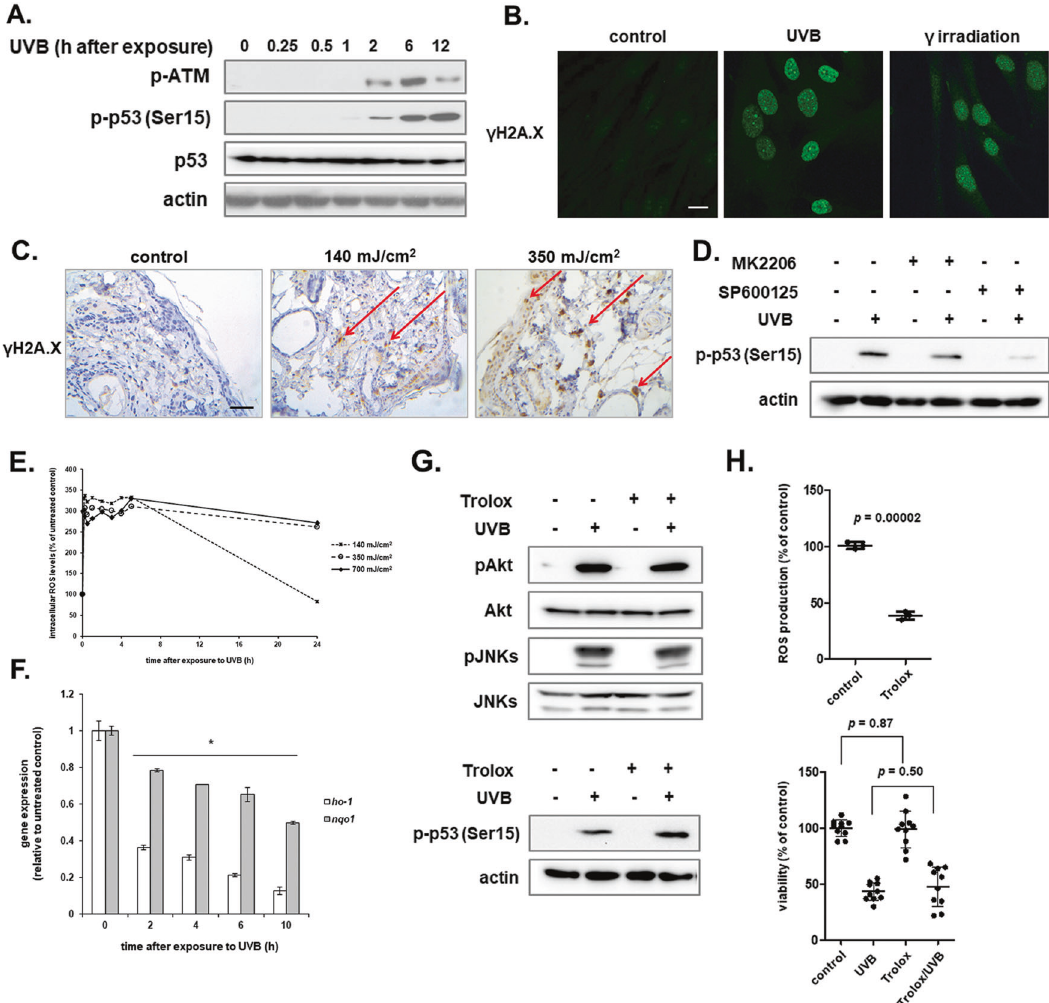
Fig. 3 UVB radiation exerts a ROS-independent genotoxic effect on human dermal fi broblasts in vitro and in vivo. A Cells were exposed to 700 mJ/cm 2 of UVB radiation before protein extraction at the designated time-points post-irradiation and western blot analysis for phopsho- ATM, phospho-p53, and total p53. Western blot analysis for actin was performed to verify equal loading. Experiments were repeated three times and representative blots are presented. B Skin fi broblasts were cultured on glass coverslips before UVB treatment with 700 mJ/cm 2 and further incubated at 37 o C for 24 h. They were then fi xed with 4% (w/v) formaldehyde followed by labeling using an antibody against phospho-H2A.X at Ser139 and a FITC-conjugated IgG. Labeled cells were visualized using a confocal laser scanning microscope. Cells exposed to 10 Gy of ionizing radiation served as the positive control. Representative images of three independent experiments are shown here. Scale bar = 20 μ m. C SKH-1 hairless mice were exposed to 140 and 350 mJ/cm 2 of UVB radiation before sacri fi ce and removal of dorsal skin 6 h post- irradiation. Non-irradiated (control) vs. irradiated tissue sections were subjected to immunohistochemical staining for the phosphorylated form of H2A.X at Ser139. Pictures shown here are representative of three independent experiments and arrows depict γ H2A.X-positive cells in the epidermis and dermis of SKH-1 hairless mouse skin. Scale bar = 50 μ m. D Cell cultures were pre-incubated with 1 μΜ of the Akt inhibitor MK2206 and 5 μΜ of the JNKs inhibitor SP600125 for 1 h before exposure to 700 mJ/cm 2 of UVB radiation, protein extraction and western blot analysis for phopsho-p53 at Ser15. Western blot analysis using an anti-actin antibody was performed for the validation of the equal loading. A representative experiment of three similar ones is depicted here. E Human skin fi broblasts were cultured in 96-well plates. When con fl uent, cells were pre-incubated with 10 μ M 2 ́ ,7 ́ -dichlor fl uorescein-diacetate (DCFH-DA) for 1 h at 37 o C and then exposed to 140, 350, and 700 mJ/ cm 2 of UVB radiation. Intracellular levels of ROS were measured at the designated time-points post-irradiation by recording fl uorescence (excitation wavelength: 485 nm, emission wavelength: 520 nm). ROS production was expressed as a % ratio of the untreated control. F Cells were exposed to an irradiation dose of 700 mJ/cm 2 and further incubated at 37 o C for 2, 4, 6, and 10 h before RNA extraction and RT-qPCR analysis using speci fi c primers for HO-1 and NQO1. The 2 − ΔΔ Ct method was applied to quantify mRNA expression and glyceraldehyde-3- phosphate dehydrogenase (GAPDH) was used as the reference gene. A representative RT-qPCR analysis performed in triplicates is depicted here. The asterisk denotes statistically signi fi cant differences in comparison to the untreated control ( p < 0.05, Student ’ s t-test). G Cells were pre-incubated with 20 μΜ of the known anti-oxidant Trolox before UVB treatment with 700 mJ/cm 2 and total protein extraction at 1 and 12 h for western blot analysis for phospho-Akt (Ser473)/JNKs and phospho-p53, respectively. Representative images of three independent experiments with similar results are shown. The non-phosphorylated forms of the kinases, as well as actin served as the loading controls. H Cells pre-incubated with 20 μΜ Trolox overnight were treated with 10 μ M DCFH-DA for 1 h at 37 o C before measurement of intracellular ROS levels. ROS production was expressed as a % ratio of the untreated control ( N = 3). In parallel, cells pre-treated with 20 μΜ Trolox overnight were exposed to 700 mJ/cm 2 of UVB radiation. Cultures were further incubated at 37 o C for 72 h before trypsinization and measurement of cell number after staining with Neutral Red using a haemocytometer ( N = 5, conducted in duplicates). Differences in comparison to the untreated control are considered statistically signi fi cant when p < 0.05 (Student ’ s t test).